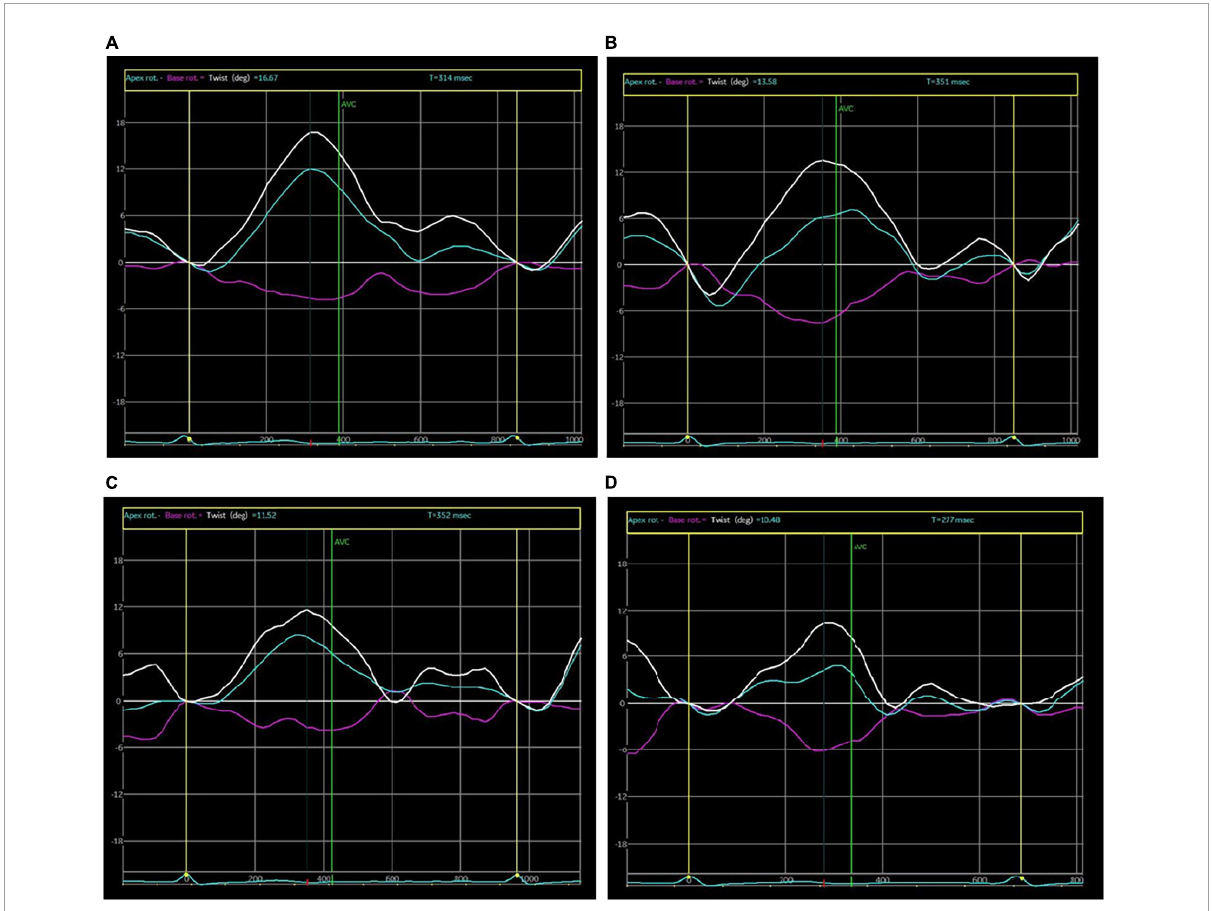
FIGURE1 Curve of left ventricular twist. (A) at baseline; (B) after 2 chemotherapy cycles; (C) after 4 chemotherapy cycles; (D) after 6 chemotherapy